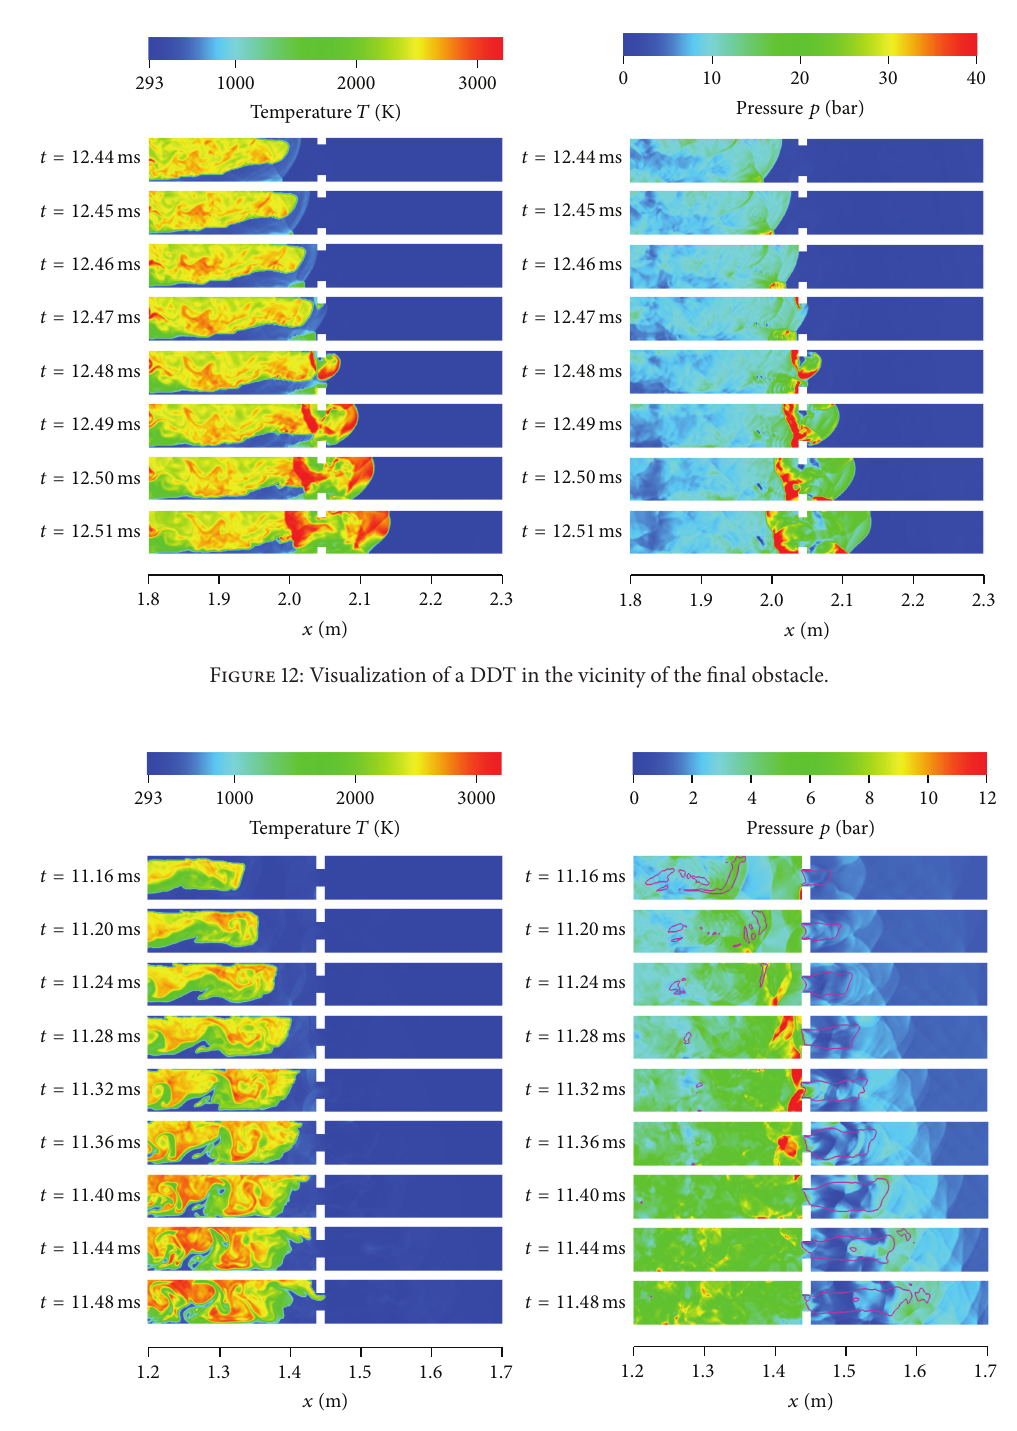
leanest. This phenomenon can be explained by taking a closer look at the shock propagation: the leading shock approaches the final obstacle at a constant speed of V ≈ 1450 m / s. Near the bottom wall the hydrogen content is 7% (see Figure 5) which results in a local speed of sound of 𝑎 = 356 m / s.